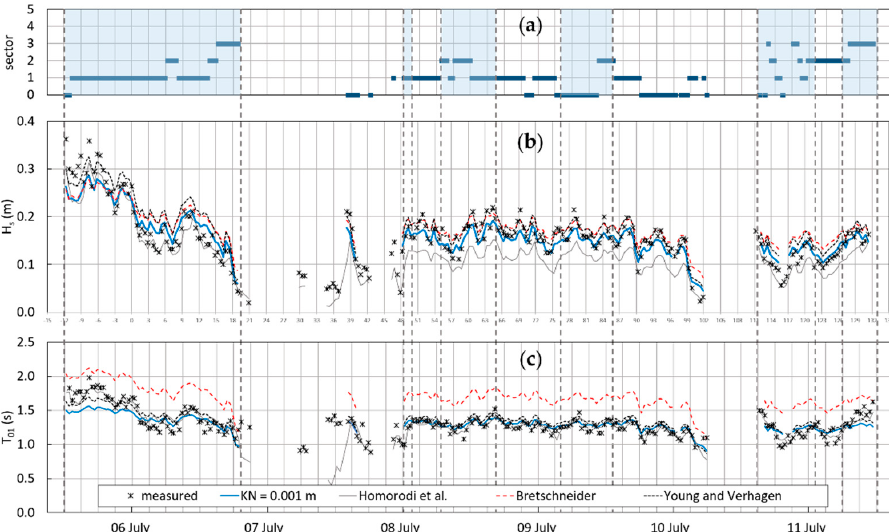
Figure 10. July 2005: ( a ) sectors of blowing winds with the selected colored records that correspond to fully developed wave conditions; ( b ) significant wave heights; ( c ) mean wave periods. Asterisks indicate measured data; the bold blue line indicates the results given by the growth curve with K N of 0.001 m, the dashed red line the forecasting values obtained with the Bretschneider formula, and the black dotted line those obtained with Young and Verhagen formula.